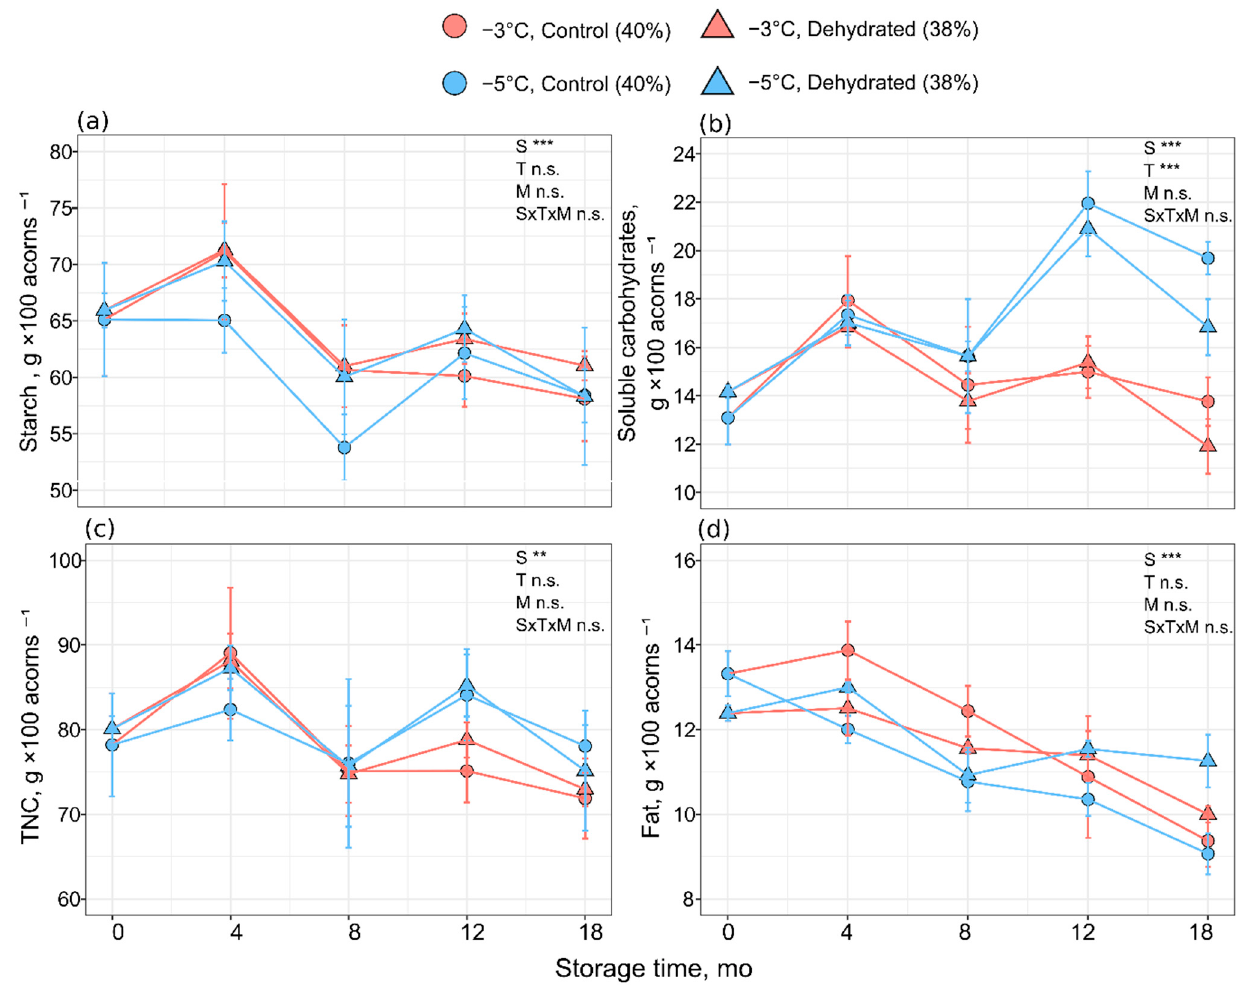
Figure 4. Contents of starch ( a ), soluble carbohydrates ( b ), total nonstructural carbohydrates (TNCs, ( c )), and fat ( d ) in acorns with 38% or 40% initial moisture content (M) stored over 18 mo at − 3 °C or − 5 °C (T). Each reserve compound pool is calculated per 100 healthy acorns. Main effects and a three-way interaction of a factorial ANOVA are given (*** p < 0.001, ** p < 0.01), with S indicating sampling date. For detailed statistical results, please see Table S1.